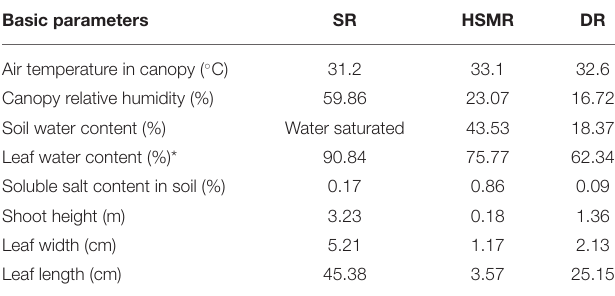
TABLE 1 | Water and salt conditions and basic parameters of three ecotypes of reed. Basic parameters